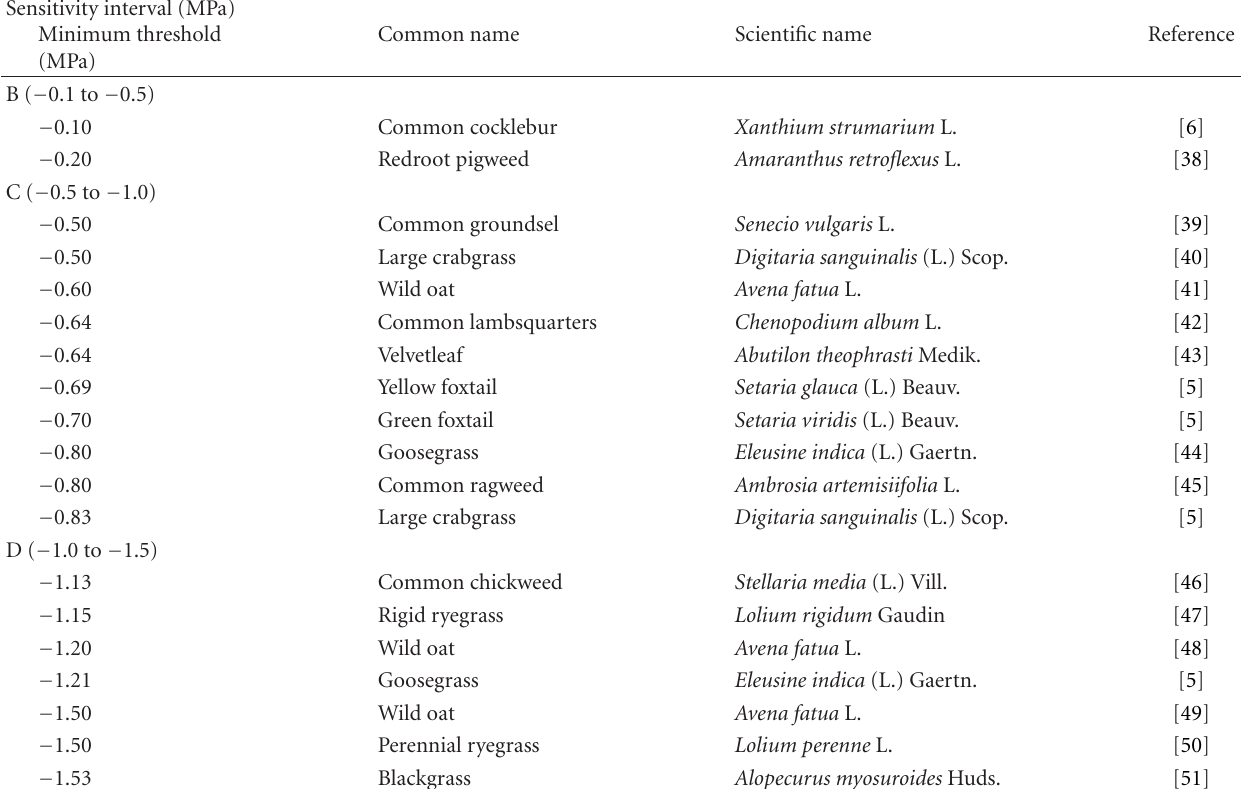
Table 4: Minimum threshold water potential for germination of weed species grouped by intervals of germination sensitivity to water